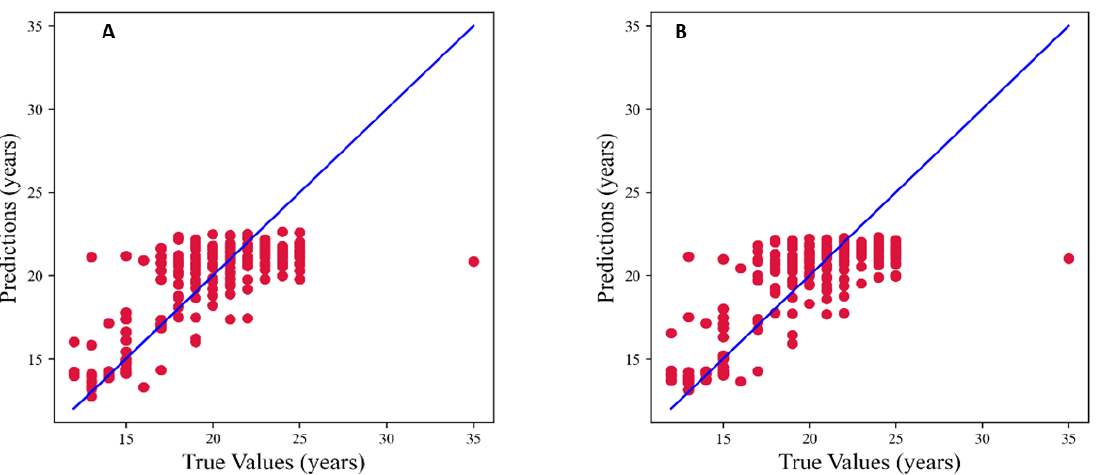
Figure 8. Plot of prediction versus true value: ( A ) Random Forest Regressor and ( B ) Extra Tree Regressor.